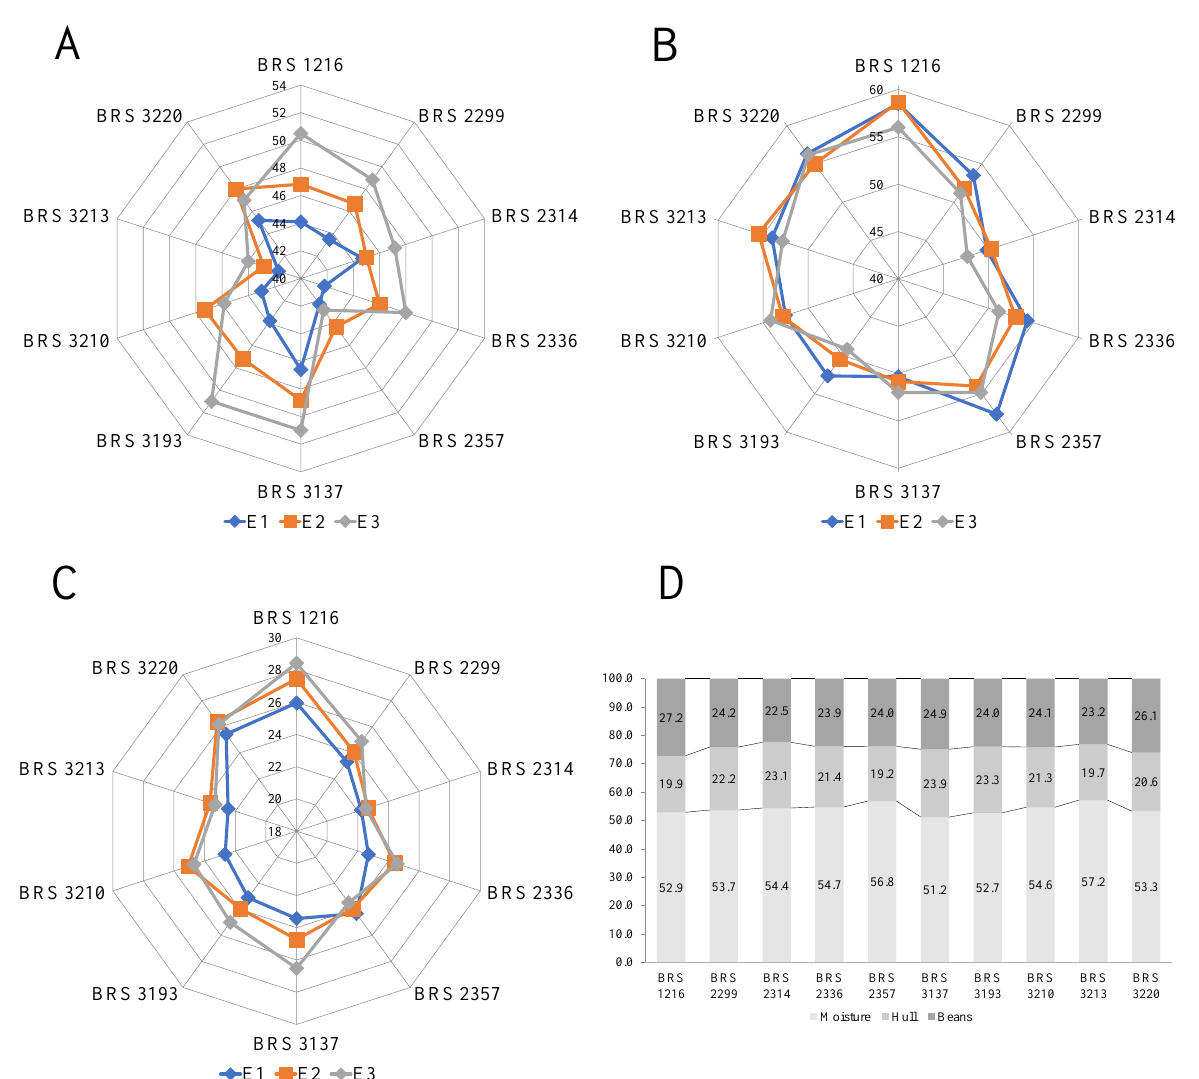
Figure 2. Distribution of weight values after drying ( A ), distribution of weight values after pulping ( B ), and outturn index estimates ( C ) of ten Amazonian Robusta cultivars evaluated in the environ- ments of Porto Velho, RO, and Ouro Preto do Oeste, RO, without irrigation (E1, E2) and Ouro Preto do Oeste, RO, with irrigation (E3). The letter ( D ) identifies the average genotype performance in relation to their moisture, hull, and bean content.